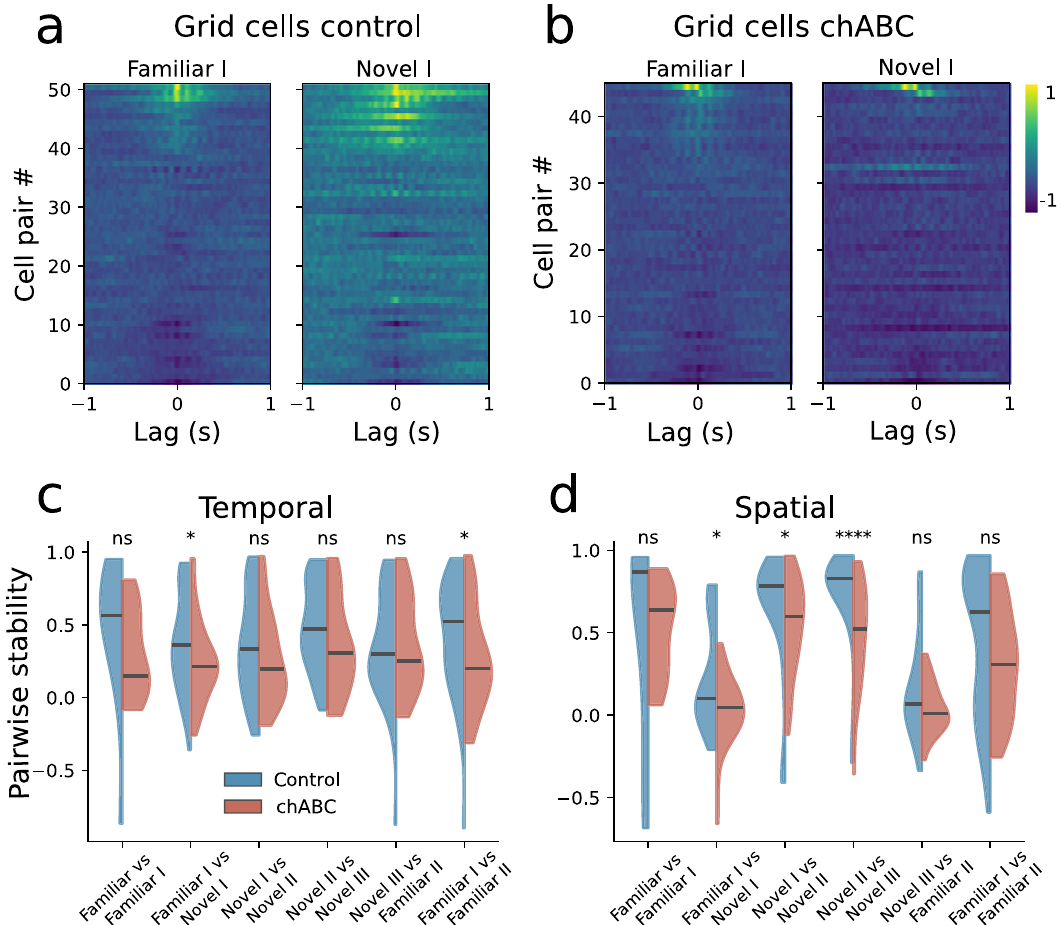
Fig. 5 PNN removal disrupt the temporal relation between grid cells. a , b Pairwise temporal cross-correlation of grid cells with brighter color showing stronger correlation. Each line represents a cell pair, sorted by maximum value of the central peak. Values range from − 1 to 1. Only cells that could be followed through the novel environment recording sessions were included. c Pairwise temporal stability calculated by correlations of pairwise correlations across recording sessions. Grid cells in the familiar environment prior to any change in environmental condition was identi fi ed and correlated with the fi rst familiar session at the day of the novel environment experiment. This is seen in the graph as Familiar vs Familiar I. The pairwise stability is signi fi cant lower for the chABC-treated group from the familiar to the novel environment (median Familiar I vs Novel I; Control 0.36 ( n = 51); chABC 0.21 ( n = 45), U